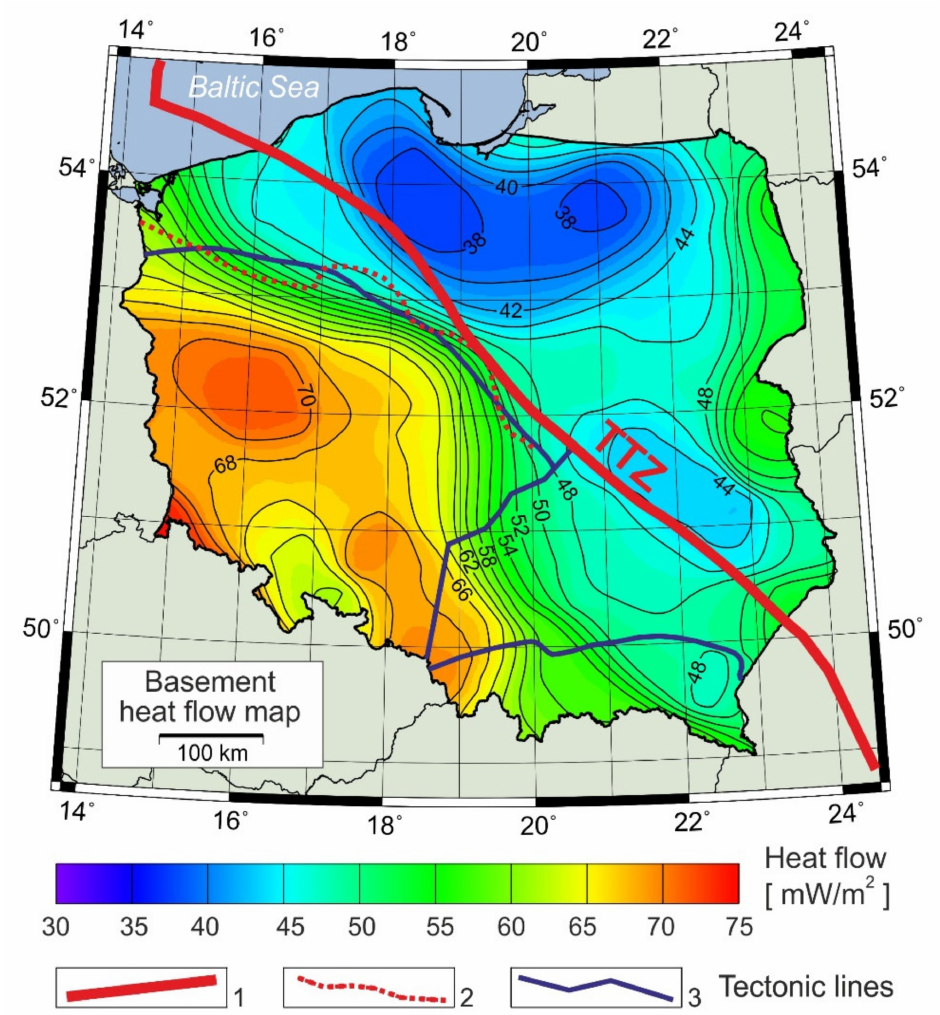
Figure 7. Newly drafted base of sediments level heat flow map of Poland. Tectonic lines: 1—position of the TTZ in Poland according to Narkiewicz et al. [38], 2—magnetic line, southern margin of the Pomeranian Massif is after Kr ó likowski [27], 3—basement borders after Karnkowski